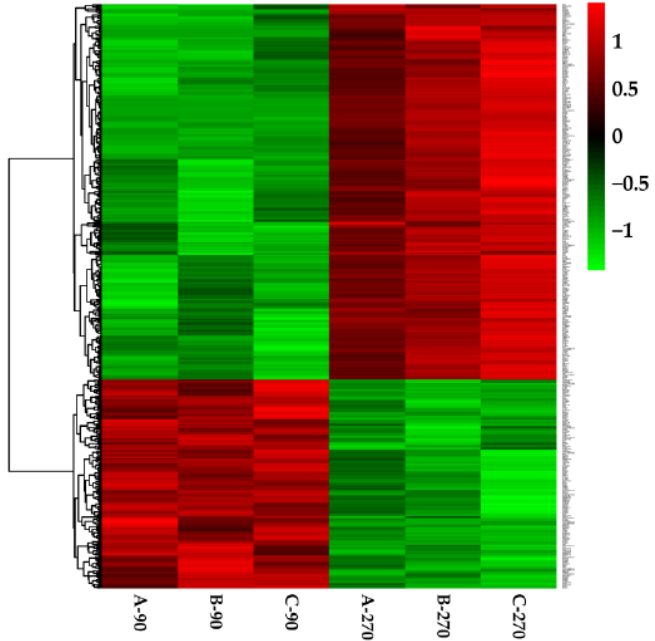
Figure 1. Heat map of the differentially expressed genes. Green indicates lower expression genes and red indicates higher expression genes.